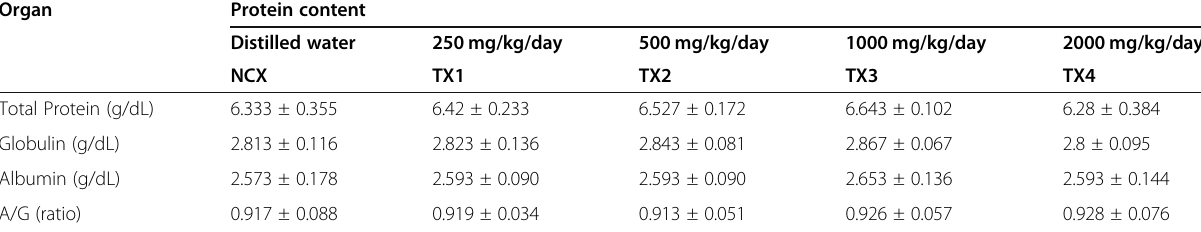
Table 7 Effect of polyherbal combination (PHC) on protein content